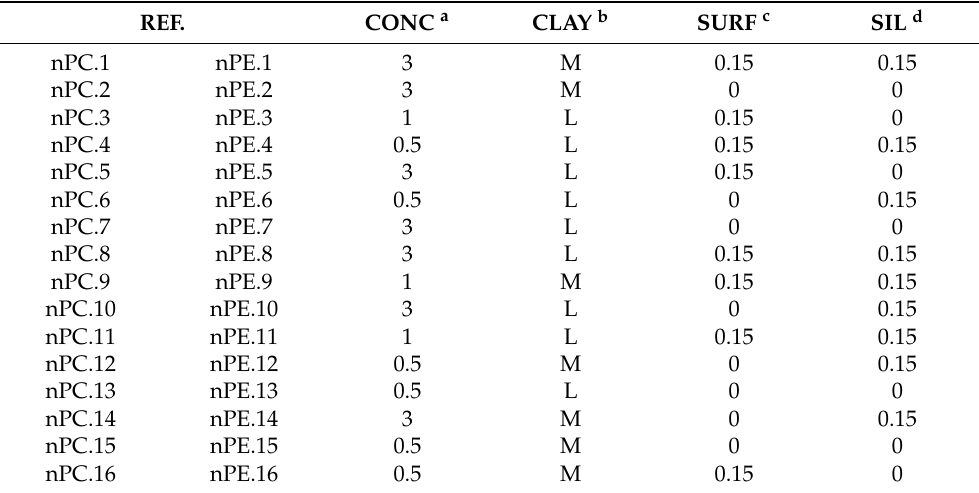
a PE-concentration; ml of matter solution, b Clay structure; montmorillonite (M) or laponite (L). c Surfactant concentration (g), d Silane concentration